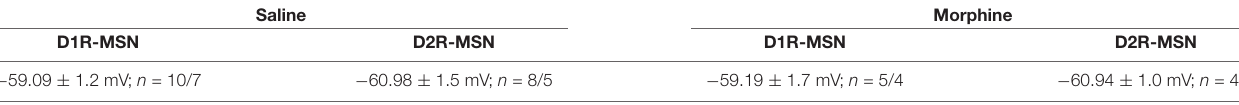
TABLE 2 | Calculated Cl − reversal potential for D1R- or D2R-MSNs in the nucleus accumbens shell. Saline Morphine D1R-MSN D2R-MSN D1R-MSN D2R-MSN − 59.09 ± 1.2 mV; n = 10/7 − 60.98 ± 1.5 mV; n = 8/5 − 59.19 ± 1.7 mV; n = 5/4 − 60.94 ± 1.0 mV; n = 4/4 Cl − reversal potential was calculated in the whole-cell patch-clamp configuration using cesium methanesulfonate internal solution with bath application of aCSF+NBQX (2 µ M) and AP5 (50 µ M). Whole-cell patch-clamp configuration was used to mimic the approach used in spontaneous EPSC and IPSC recordings ( Figure 2 ). The values were corrected with